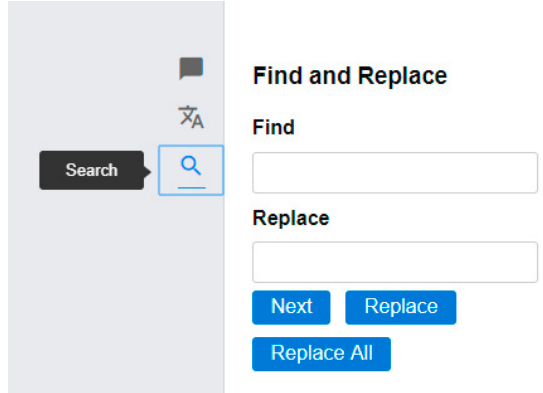
Figure 2. Interface of our initial prototype showing the Edit view with additional features.